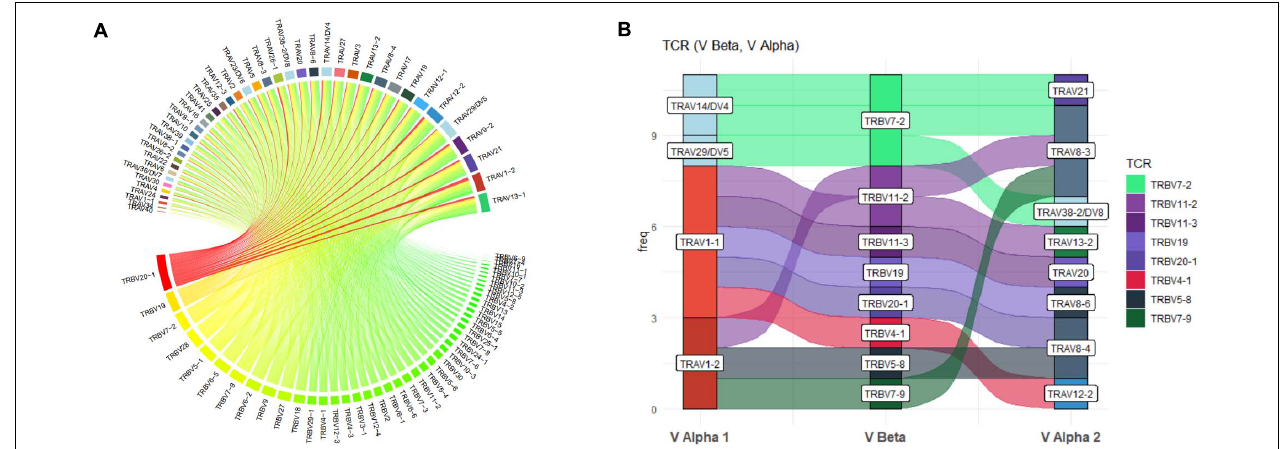
FIGURE 3 | Circos and Sankey plots to display holistic clonality, dominance, and complex pairings. (A) Circos plots provide an overview of TCR pairing clonality and dominance within a selected sample as shown for TRAV and TRBV pairings and can also be produced for paired CDR3. Alpha genes are listed at the top and paired to respective β genes at the bottom with width and color (red to green) of each segment proportionate to comparative dominance of total functional TCR pairings. (B) Sankey plot illustrating more complex gene interactions identified by sequencing, shown for TRAV-TRBV-TRAV triad, detailing clone frequency on y